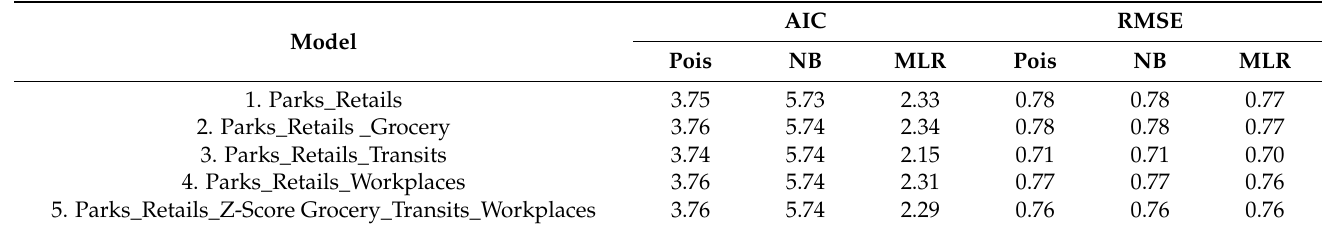
Table 3. Poisson GLM, Negative Binomial GLM, and Multiple Linear Regression of COVID-19 Daily Confirmed